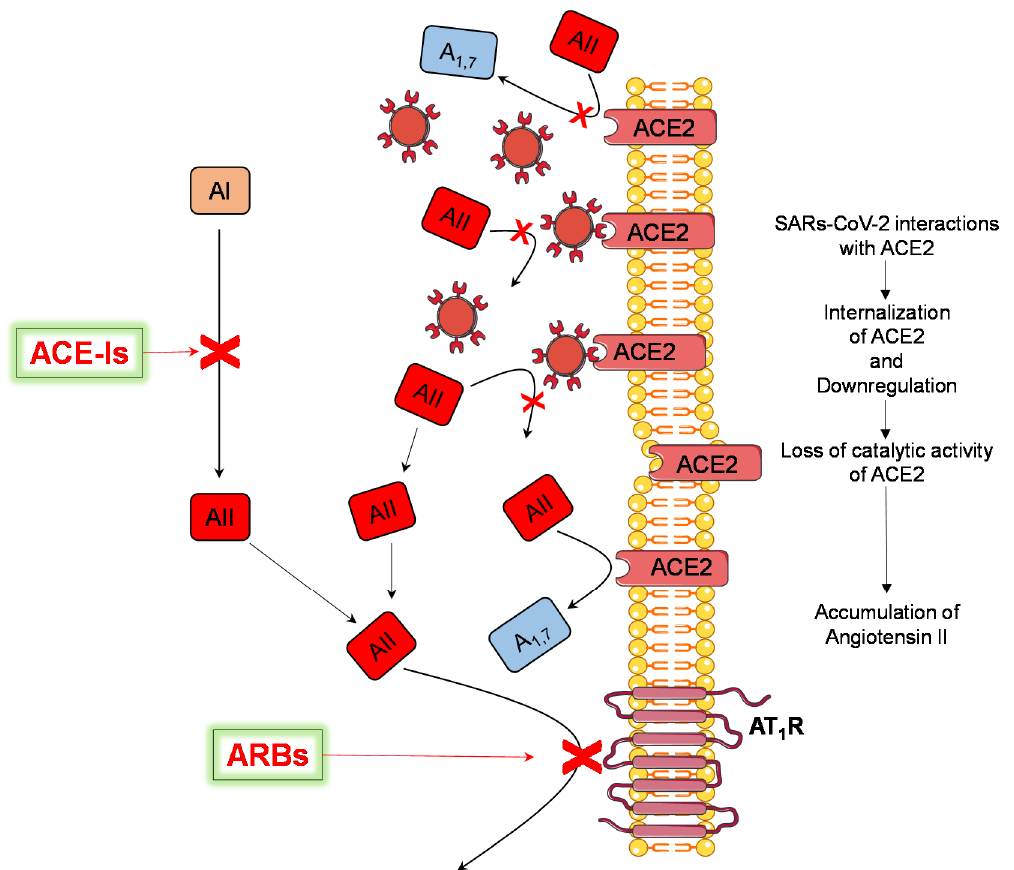
Figure 4. Potential mechanisms of pharmacological modulation of the renin–angiotensin system to reduce the deleterious effects of angiotensin II accumulation. AI = angiotensin I; AII = angiotensin II; A 1,7 = angiotensin 1–7 ; ACE2 = angiotensin-converting enzyme 2; ACE-Is = ACE inhibitors; ARBs = angiotensin receptor blockers; ATR1 = angiotensin II type 1 receptor.